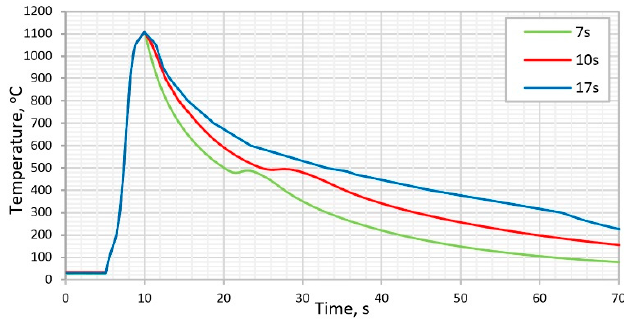
Figure 8. Thermal cycle from the Gleeble physical simulation with different cooling times t 8/5 .